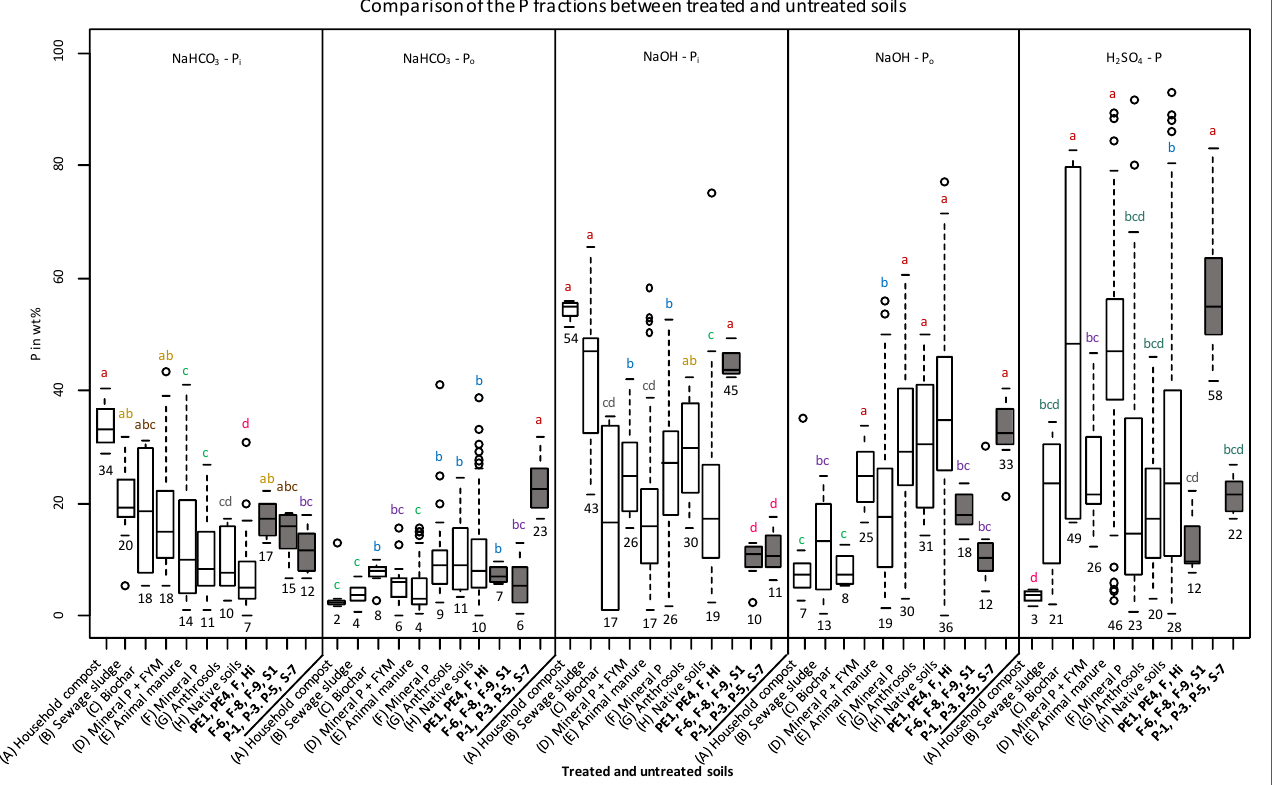
Figure 8. Box plot of the relative proportions of the P-fractions as percent of the sum of fractions (NaHCO 3 -P i + NaHCO 3 -P o + NaOH-P i + NaOH-P o + H 2 SO 4 -P) in the Anthrosols of the present study, in reference soils with different amendments, in other Anthrosols, and in native soils. References: A: [51]; B: [51,52,90,91]; C: [92]; D: [93 – 98]; E: [51,53,58,83,93 – 107]; F: [51,58,62,93,94,96 – 98,100,104,106 – 112]; G: [109,110]; H: [52,83,91,93,100,103 – 105,110,113 – 123], Negassa W. (unpublished data).